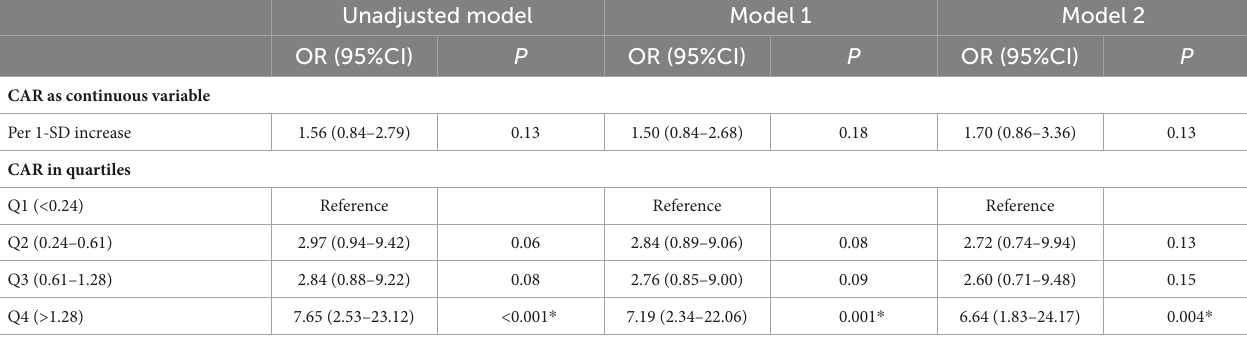
TABLE 3 Multivariate logistic regression to assess the potential relationship between CAR and